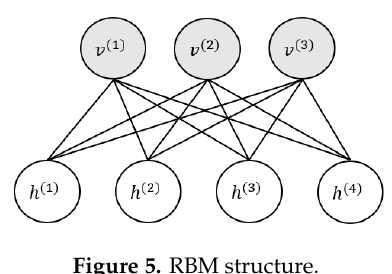
Figure 5. RBM structure.